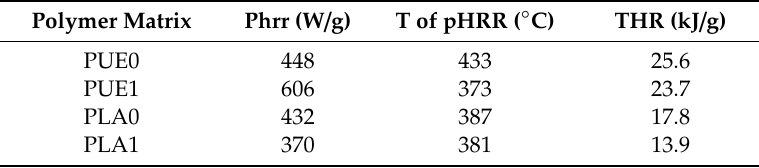
Figure 3. Pyrolysis combustion flow calorimeter (PCFC) curves for PUE/APP and PLA/APP composites. Table 2. PCFC results for PUE/APP and PLA/APP composites.